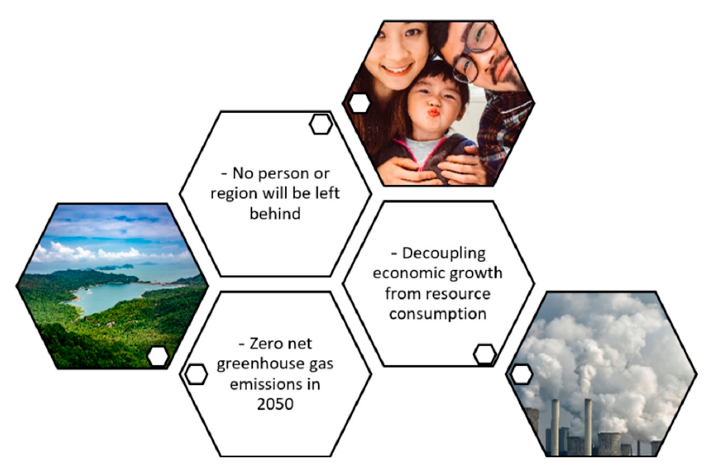
Figure 3. Diagram presenting linear and circular economies, source: own study based on [17].